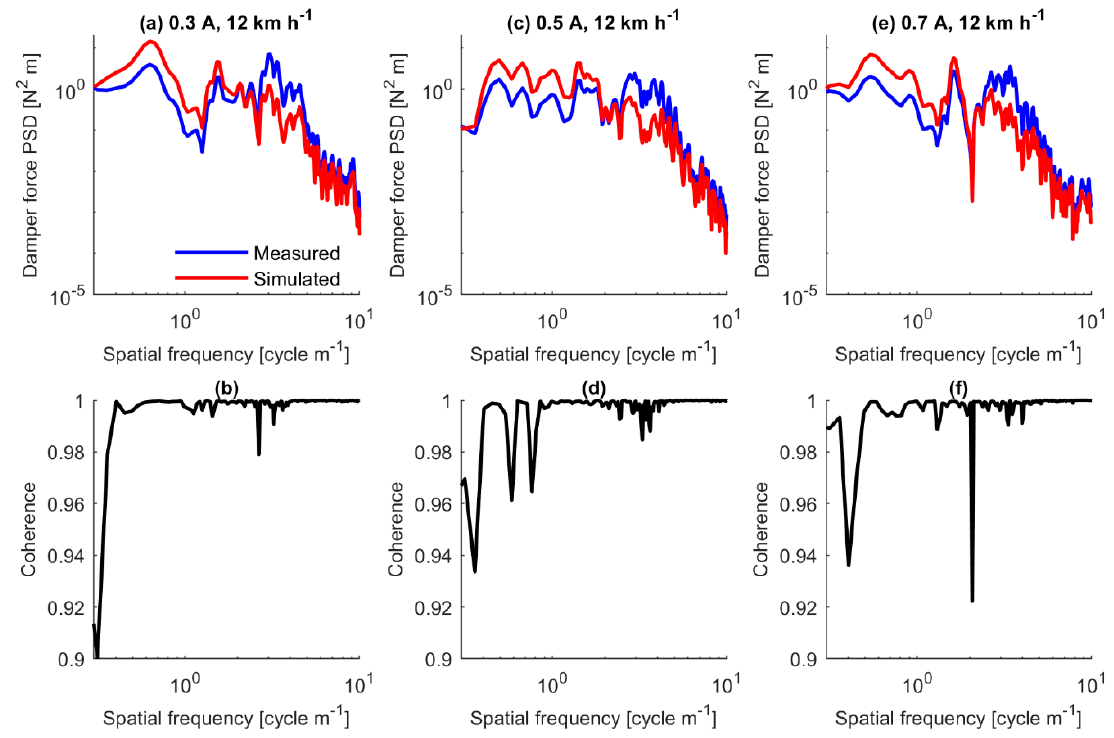
Figure 9. ( a , c,e ) Power Spectral Density (PSD) of the measured and the simulated damper forces when the MR damper supplied with 0.3 A, 0.5 A, and 0.7 A and a traveling speed of 12 km h − 1 , and ( b , d , f ) the corresponding